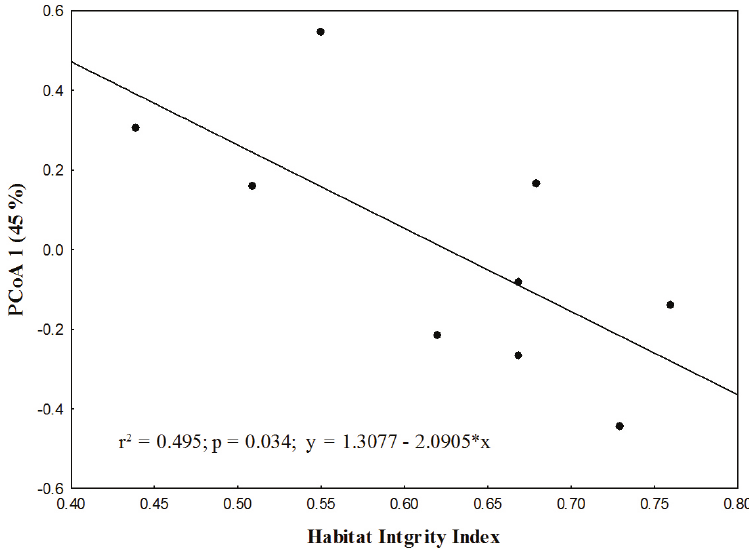
Figure 3. Relationship between the Habitat Integrity Index and the PCoA 1 for nine streams in southern Amazon, Querência municipality, Mato Grosso State,